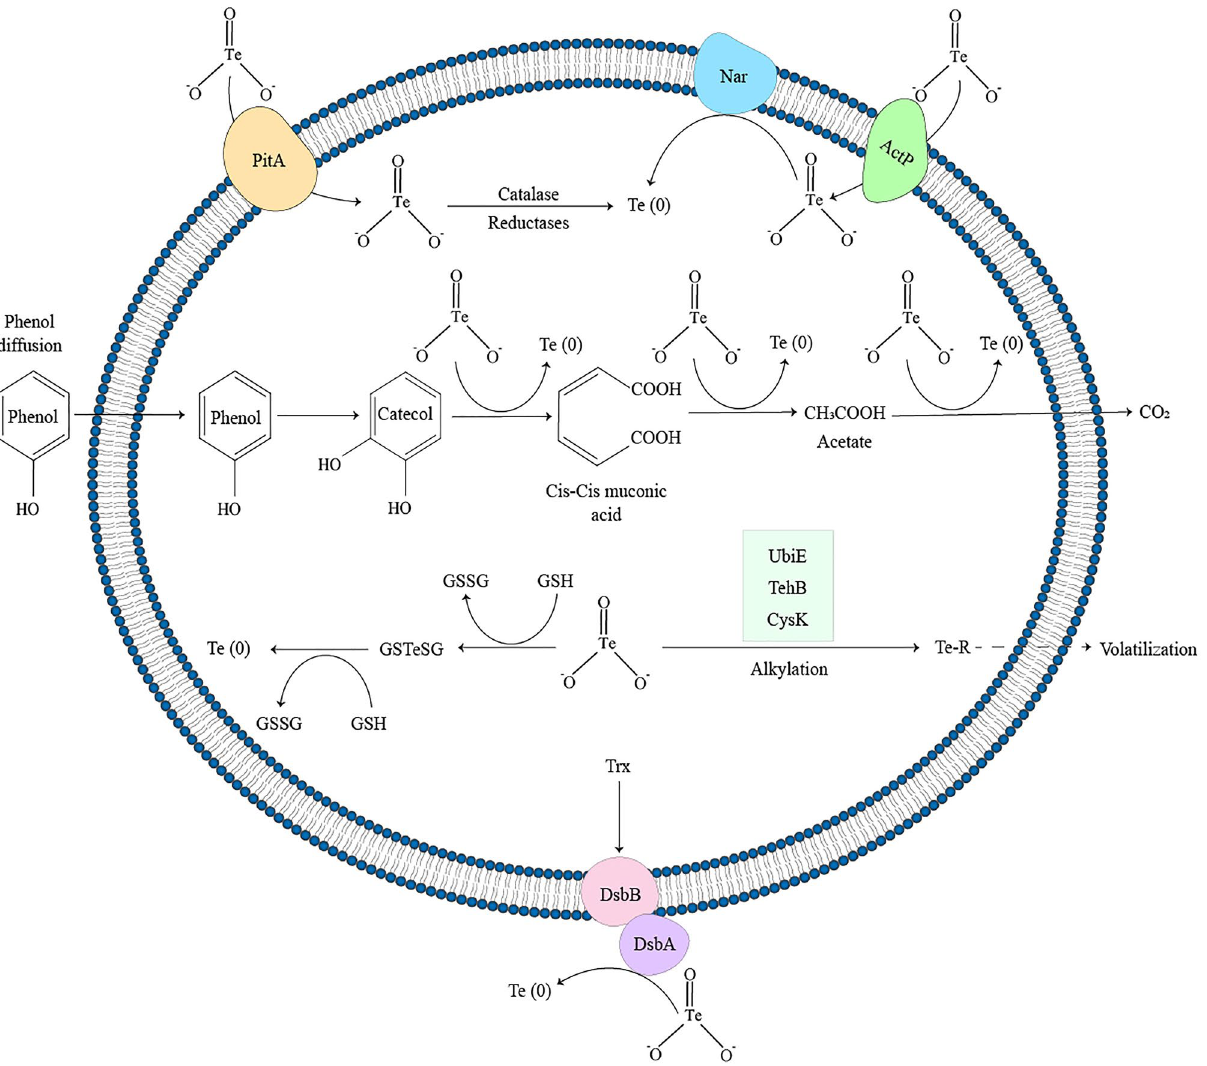
Figure 2. The proposed mechanism for degradation of phenol coupled with reduction of tellurite to TeNPs by Lysinibacillus sp. EBL303 (created by Adobe Illustrator 2022, https:// www. adobe. com/ produ cts/ illus trator.